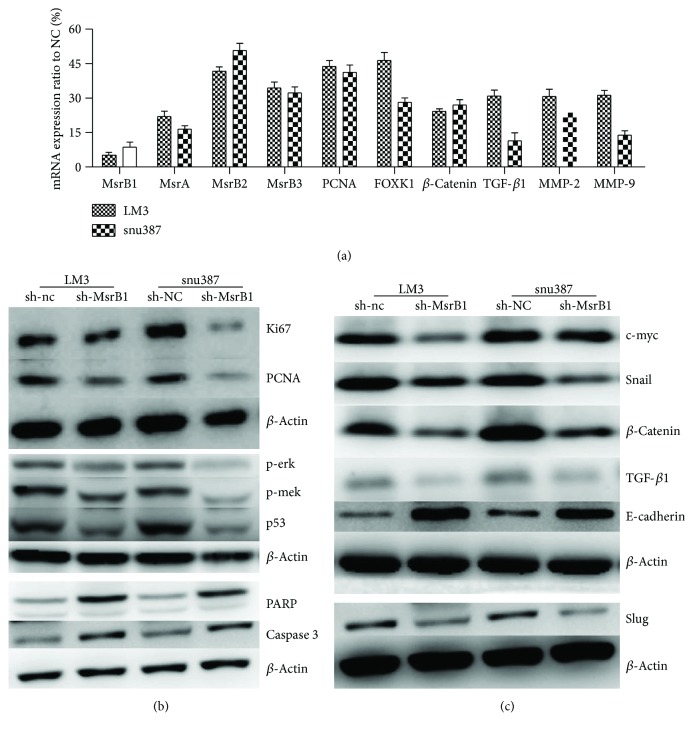
MsrB1 affects proliferation/migration of HCC cells by inhibition of the MAPK pathway, inducing apoptosis and inhibition of EMT. (a) The mRNA expression of MsrA/B2/B3, PCNA, FOXK1, β-catenin, TGF-β1, and MMP2/9 was regulated in MsrB1-knockdown cells. (b) The expression of protein phosphorylation of the key proteins of the MAPK pathway, namely, ERK, MEK, and level of p53, was inhibited, but activation and cleaved PARP and caspase 3 expression levels change reflective proliferation inhibition. (c) MsrB1 knockdown increased E-cadherin expression levels. However, MsrB1 knockdown decreased c-myc, Snail, TGF-β1, Slug, β-catenin, MMP-2, and MMP-9 expression levels, indicating that MsrB1 knockdown inhibited EMT.